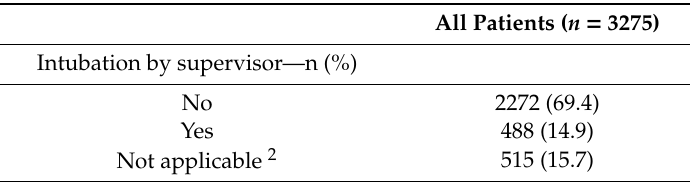
Table 3. Description of patients for whom intubation failed ( n = 105).